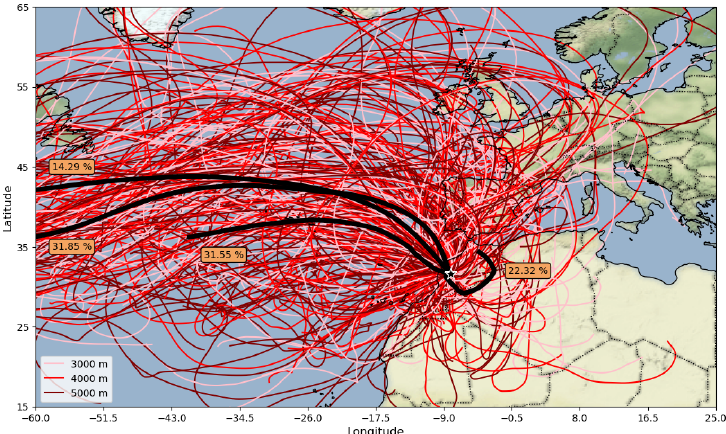
Figure 13. HYSPLIT climatological modelling showing the trajectories of aerosols located over Saada during winter from 2005 to 2020 for upper height